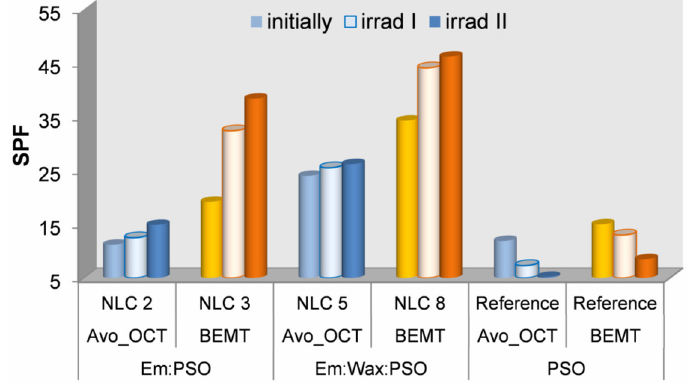
Figure 12. SPF values of the creams based on lipid nanocarriers synthesized with different lipid matrices exposed to UV radiation.